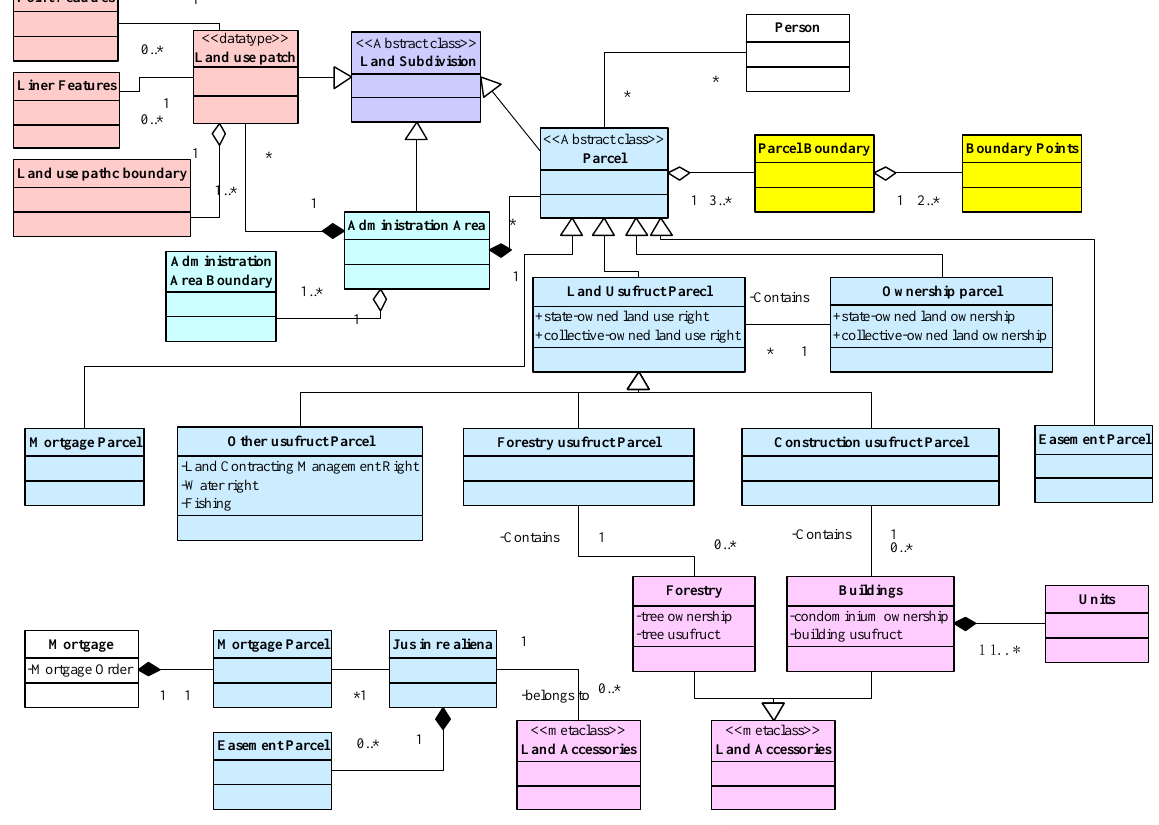
Figure 8. Cadastral domain model of